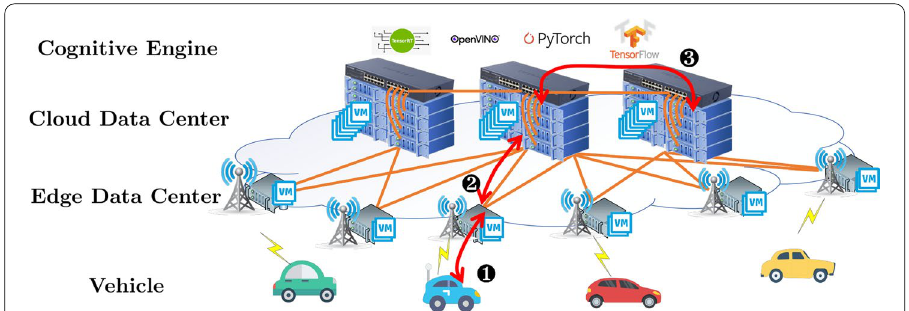
Fig. 1 The framework of cognitive internet of